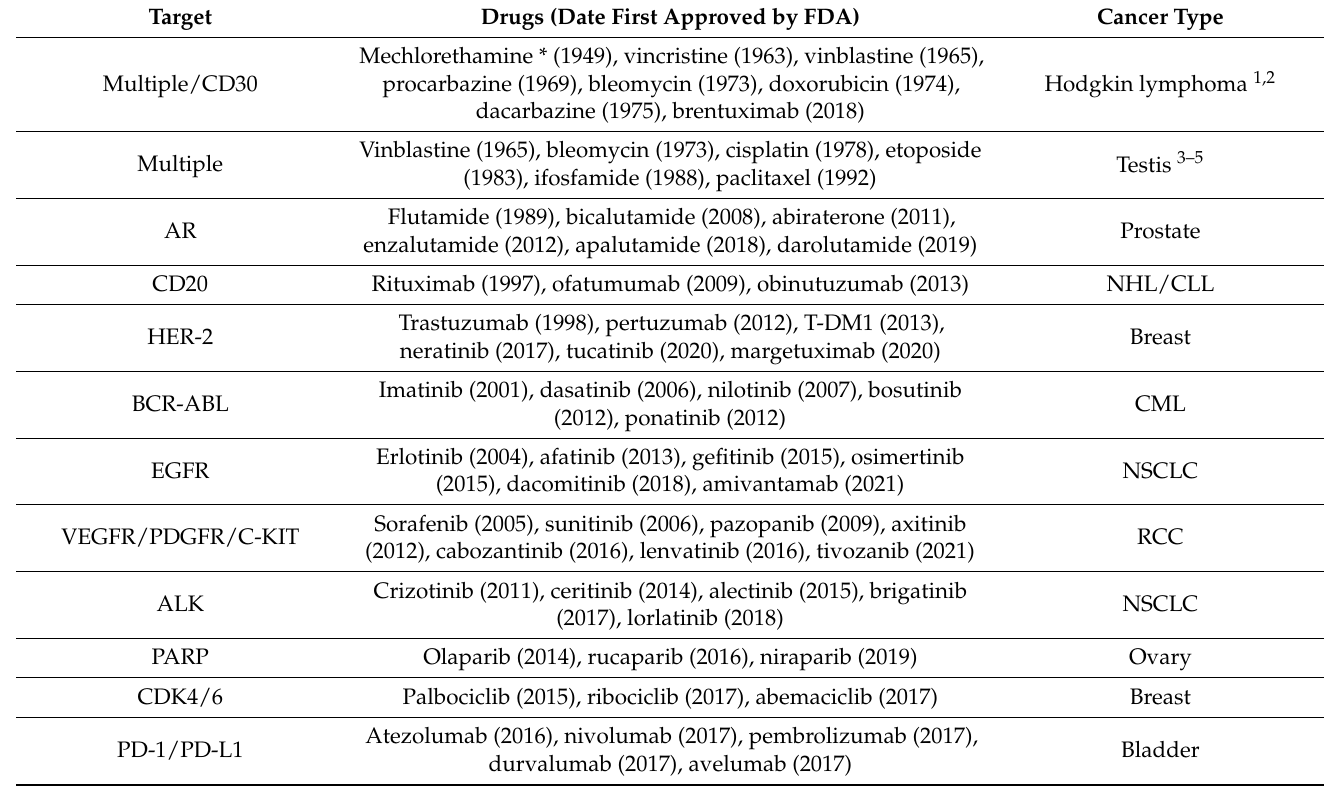
Table 1. Drug development in cancer care: an abbreviated and representative